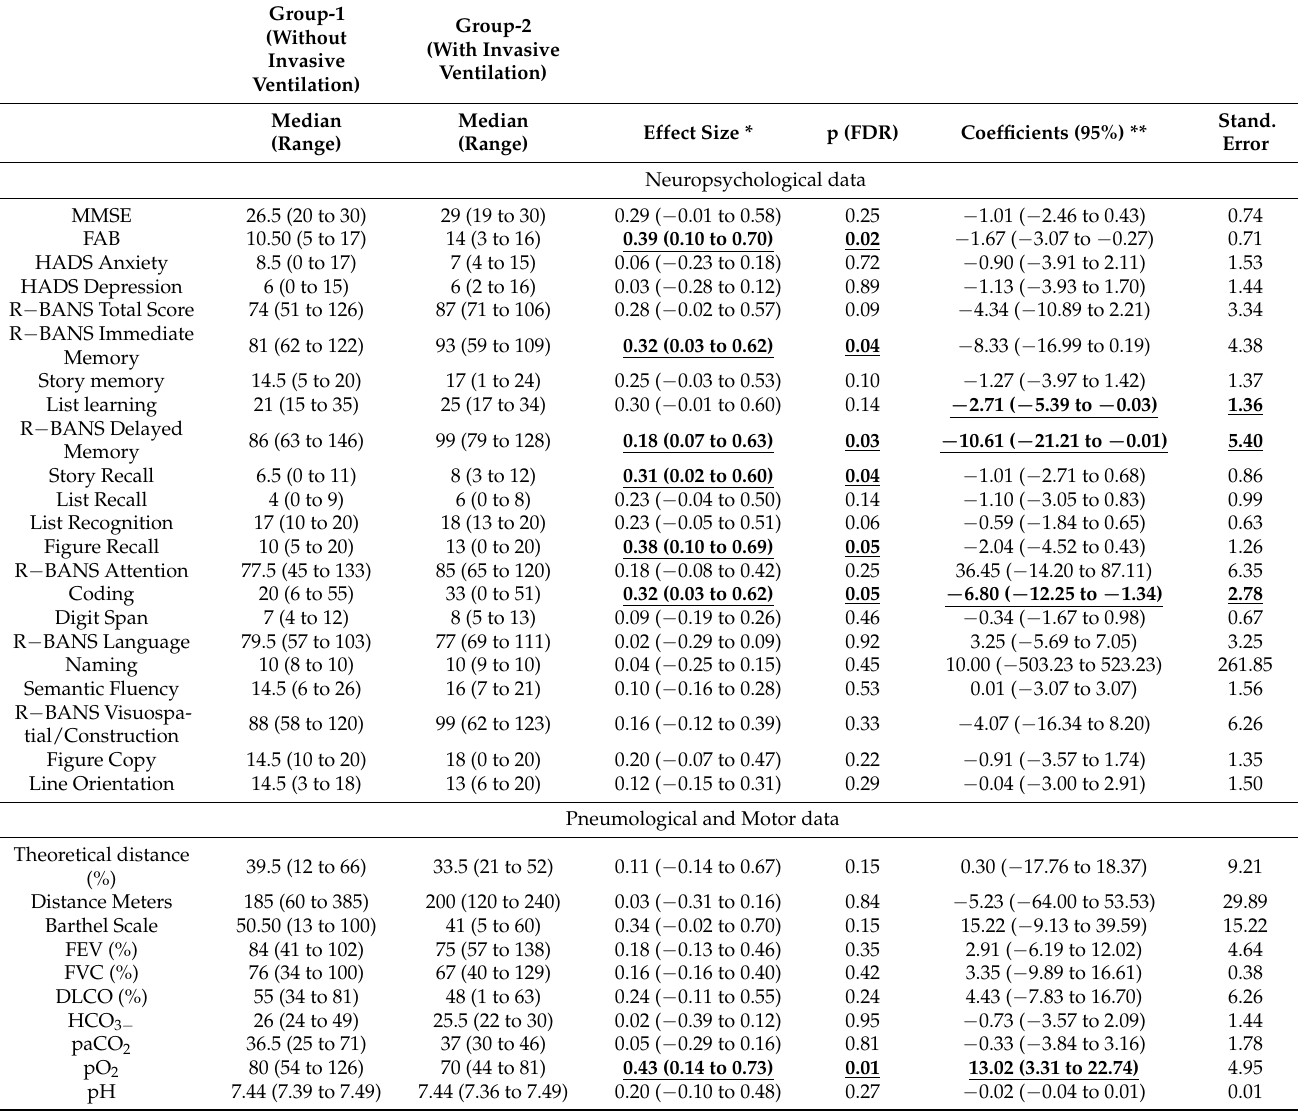
Table 2. Neuropsychological, pneumological, and motor data for the two samples ( n =